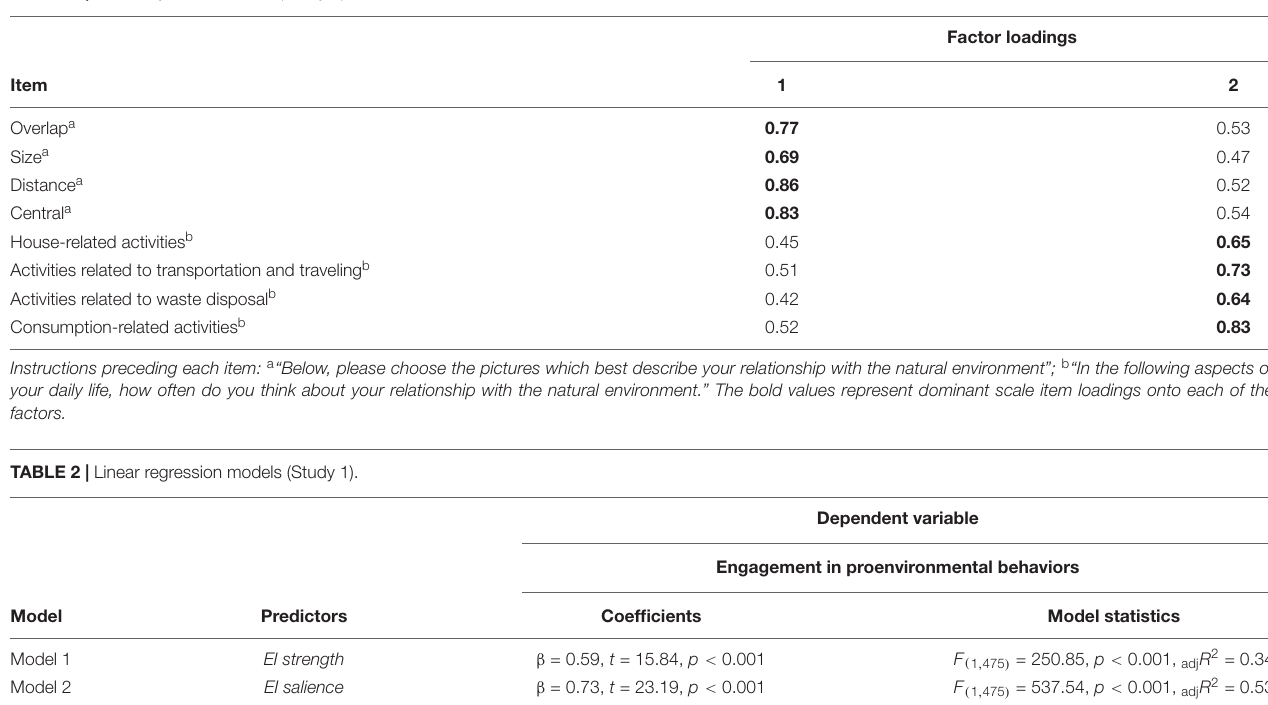
TABLE 1 | Summary of EFA results (Study 1).